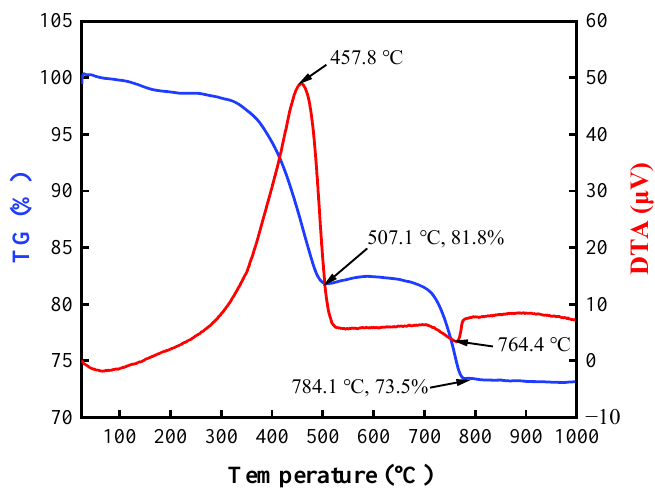
Figure 7. TG/DTA curves of the BFA.